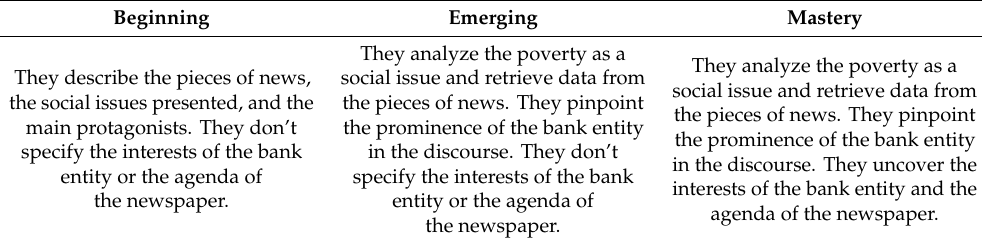
Table 1. Rubric utilized to analyze results of activity 1.